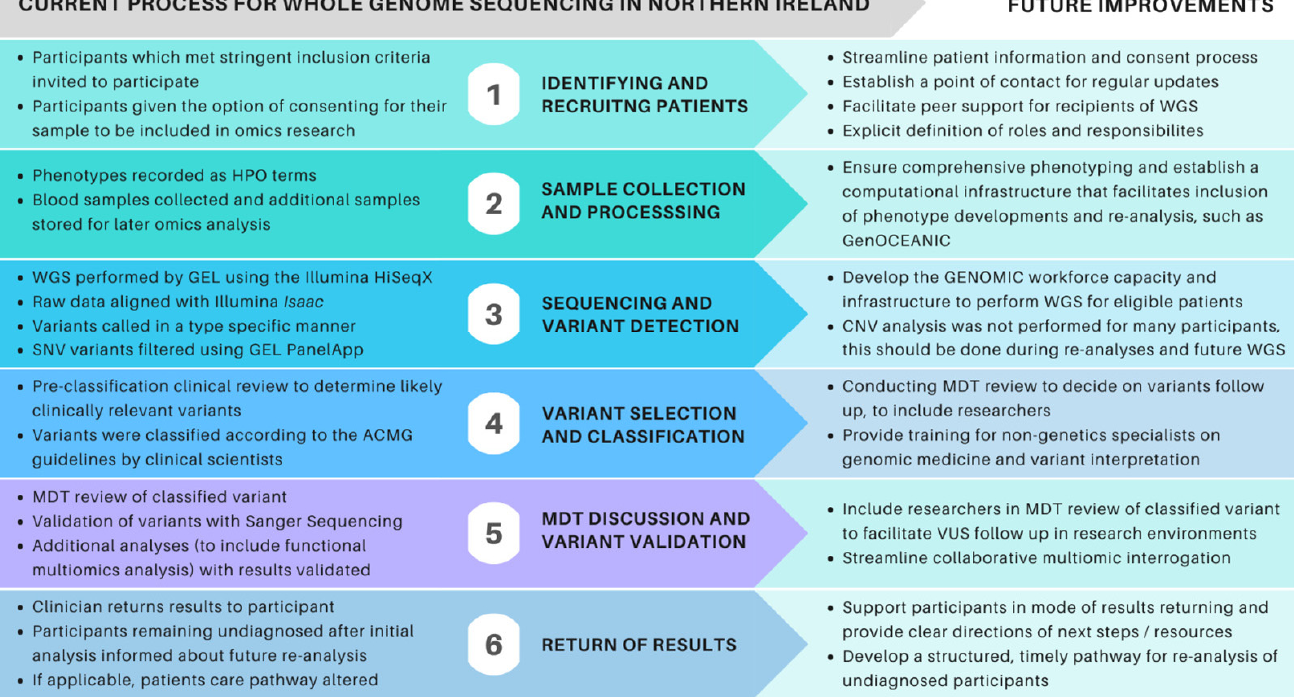
Figure 2. Summary of the workflow and recommendations for future implementation of WGS in